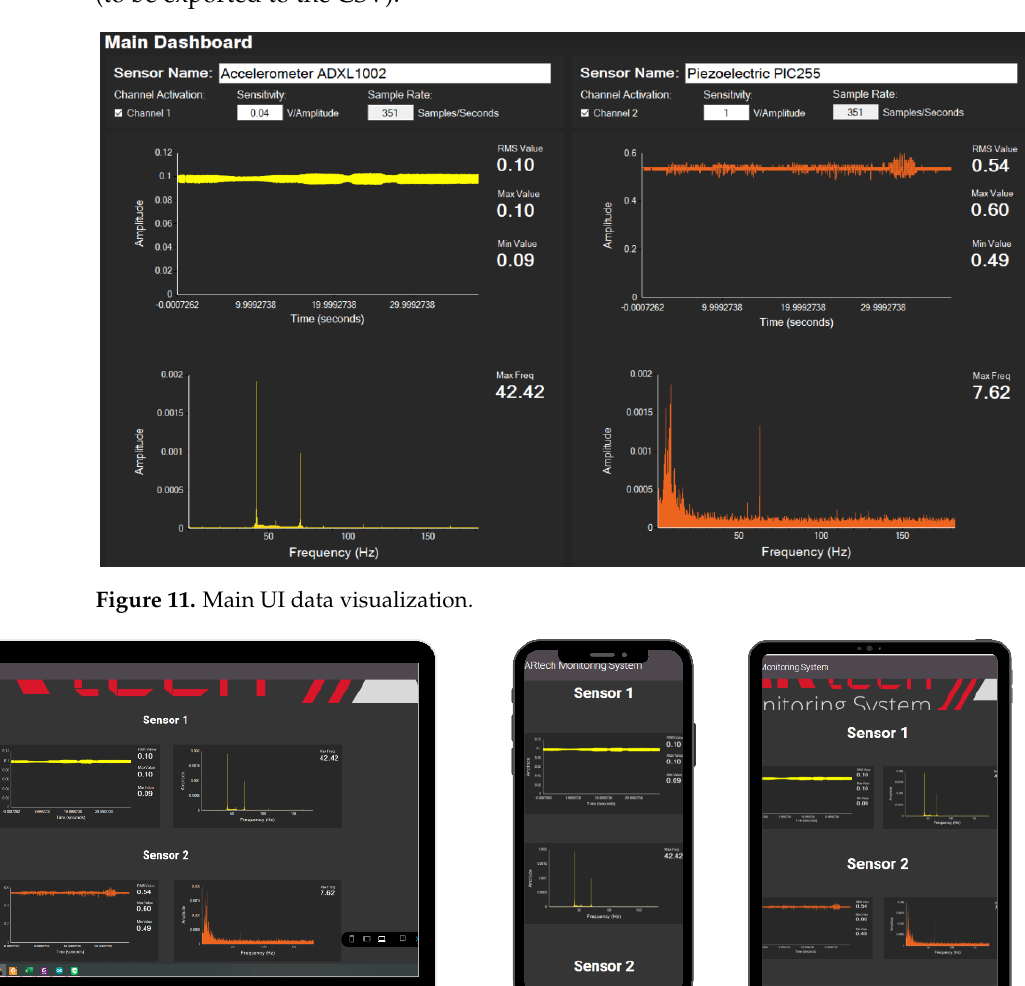
Figure 12. CPMA website data visualization.